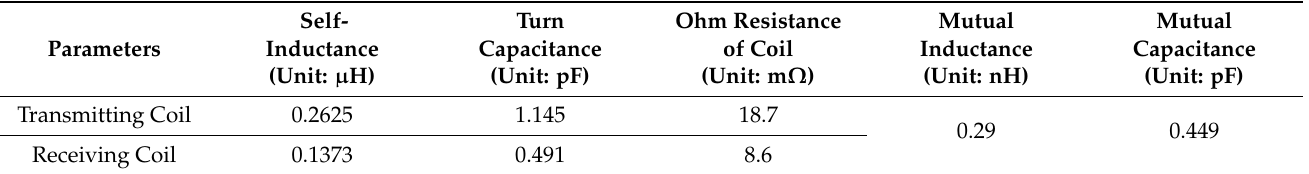
Table 3. The extracted equivalent circuit parameters of the orthogonal dual-coil